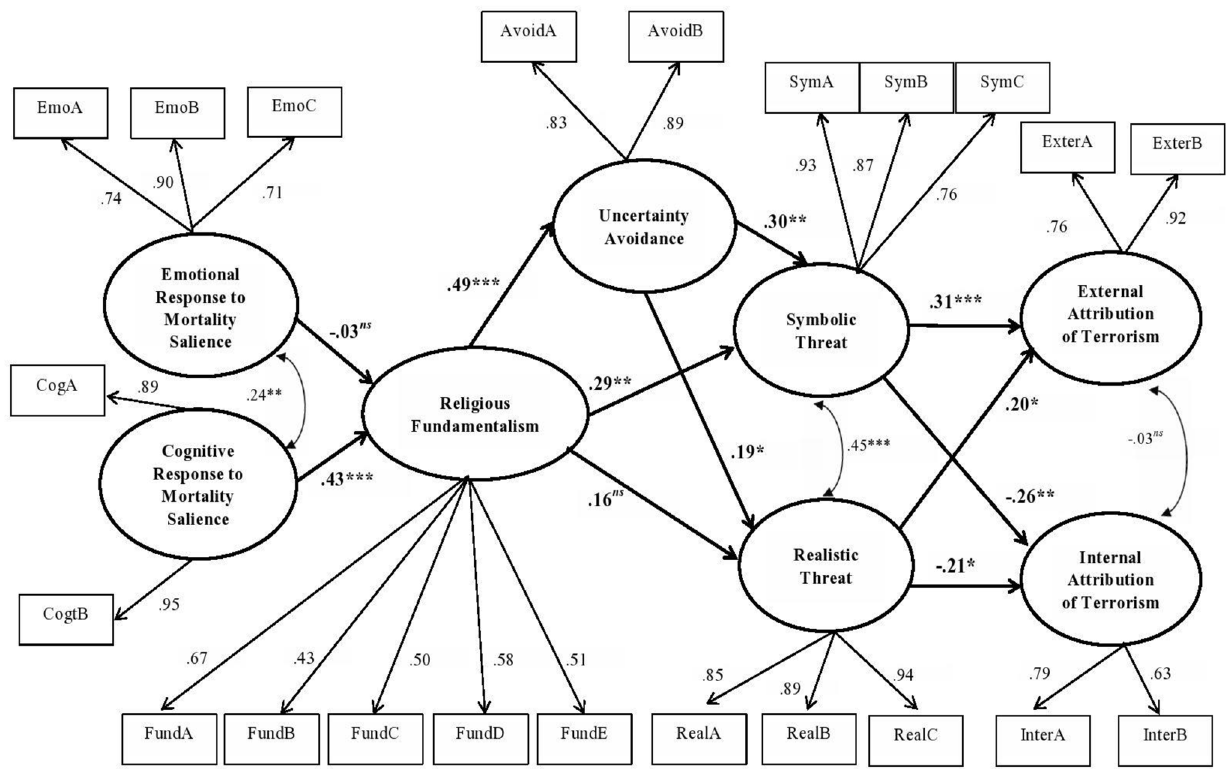
Figure 1. The hypothesized full model of the relationships among external attribution of terrorism, internal attribution of terrorism, symbolic threat, realistic threat, uncertainty avoidance, Islamic fundamentalism, cognitive response to mortality salience and emotional response to mortality